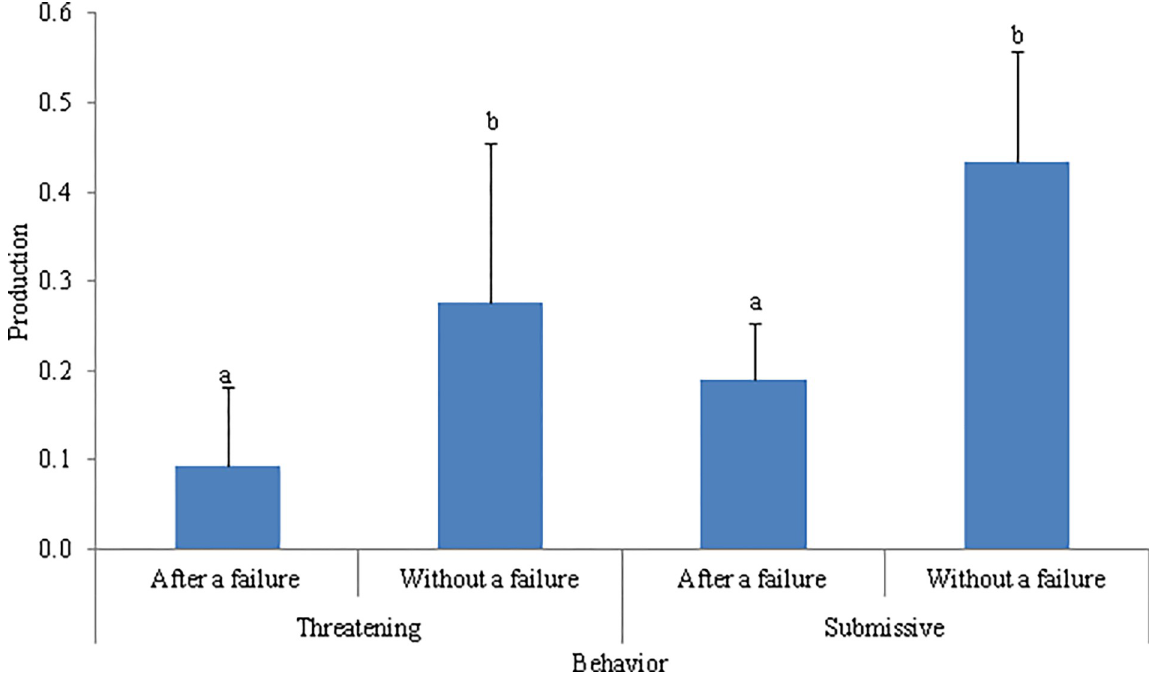
Fig 1. Mean (log-transformed) production of multimodal signals by white-lipped peccaries (N = 21). Animals may be displaying threatening or submissive behavior according to temporal occurrence. Production occurred either after a unimodal signal failure or without a previous unimodal signal failure. Error bars denote SE of means. Different letters above bars within the same behavior represent a significant difference ( P < 0.05). https://doi.org/10.1371/journal.pone.0280728.g001 (F = 34.97, P < 0.001) (Table 4). The post hoc linear regression analyses, however, showed 1, 34 no significant relationships between the sender’s MDS in the production of unimodal signals when WLPs were displaying either threatening (F = 2.80, R 2 = 0.08, P = 0.107) or submis- 1, 19 sive (F = 1.91, R 2 = 0.04, P = 0.181) behaviors. While regarding the production of 1, 19